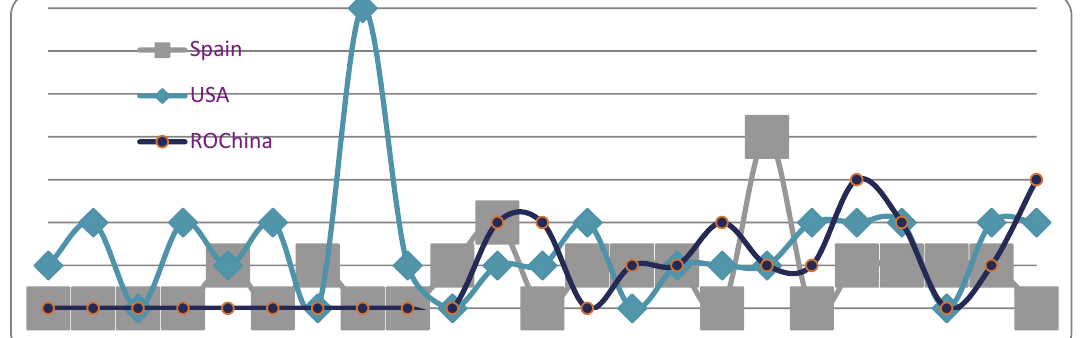
Fig. 5. Number of Life Insurance Efficiency Studies When Taking Multiple Nation Studies into